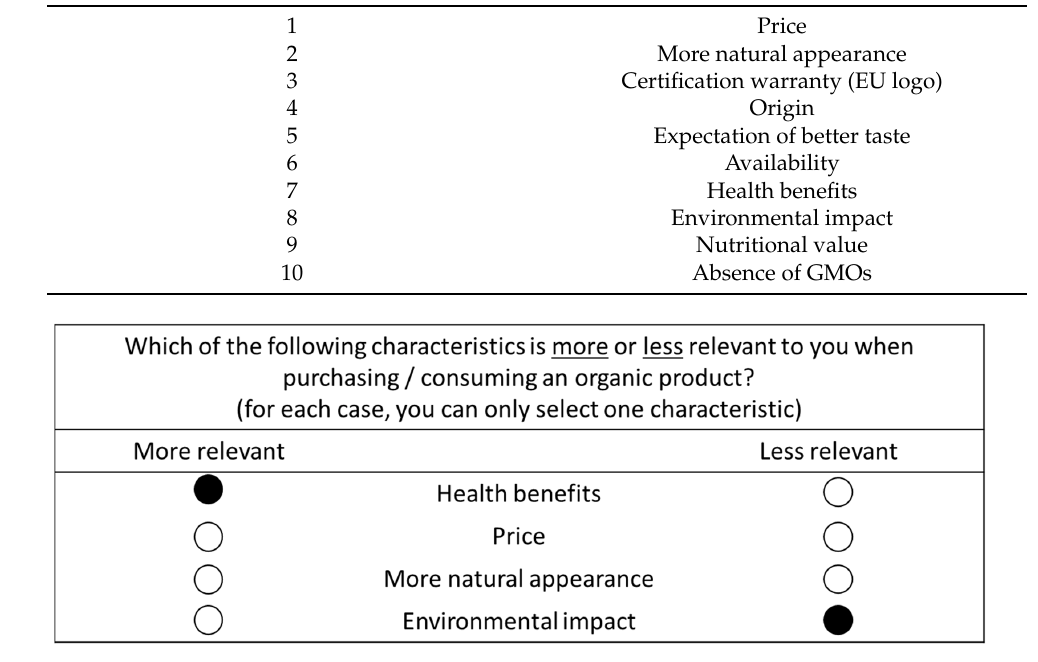
Figure 1. Choice Set illustration. In this example, the respondent chooses the attribute “Health benefits” as the most relevant, and the attribute “Environmental impact” as the least relevant, and no more circles can be selected.